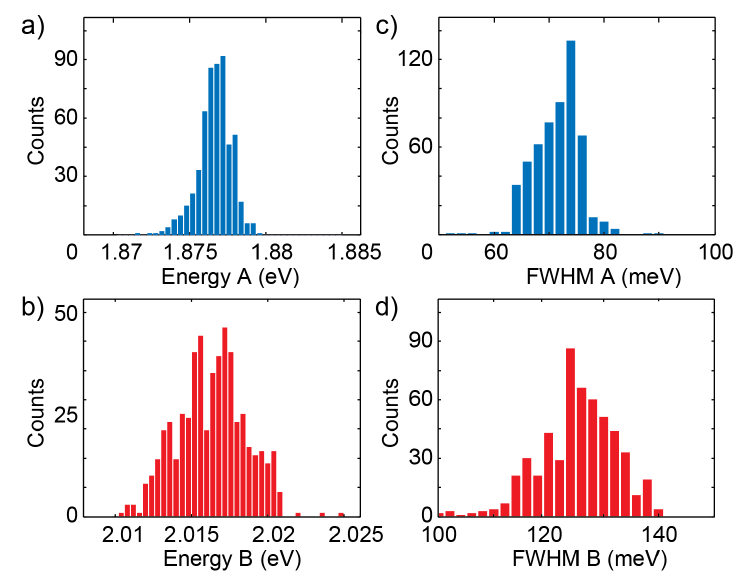
Figure 3. Extracted data from Differential reflectance measurement: ( a , b ) Histograms of the A and B exciton energy for 550 flakes. ( c , d ) Histograms of the full width at half maximum of the A and B excitons peaks.